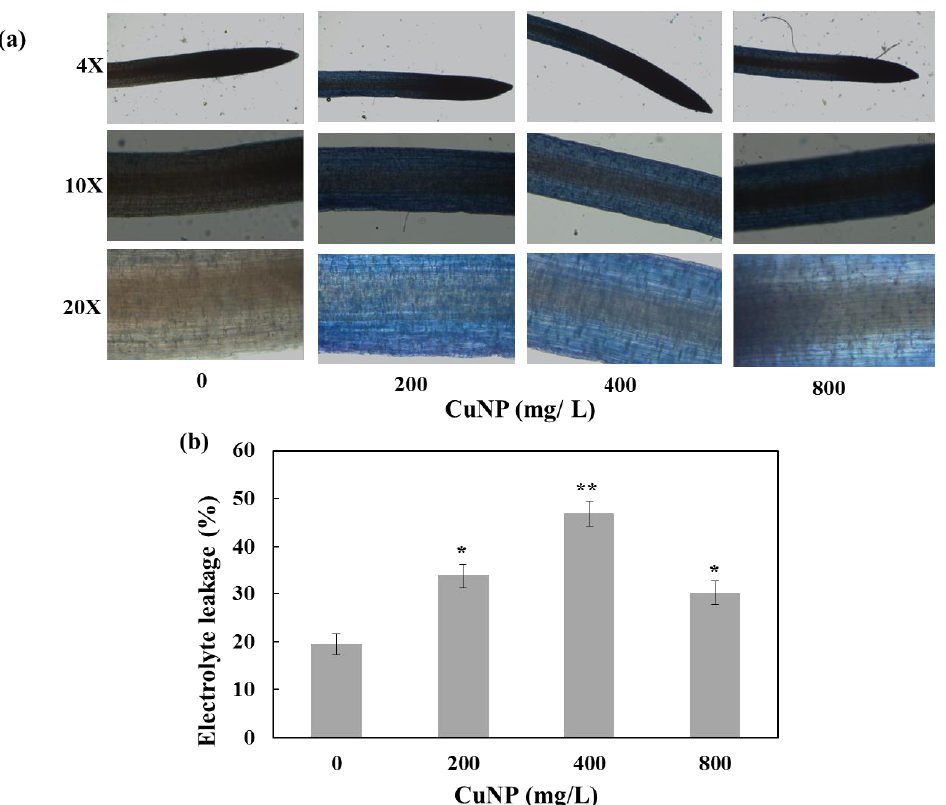
Figure 2. Evan’s blue and electrolyte leakage analysis of C. sativum plants after 7 days of exposure to 200 mg/L, 400 mg/L and 800 mg/L of CuNPs. ( a ) plasma membrane integrity of roots monitored under 4 × , 10 × and 20 × magnifications using Evan’s blue staining. ( b ) electrolyte leakage analysis of C. sativum plants. The values are mean ± se ( n = 3). Statistically significant difference was calculated at * p ≤ 0.05, ** p ≤ 0.01.